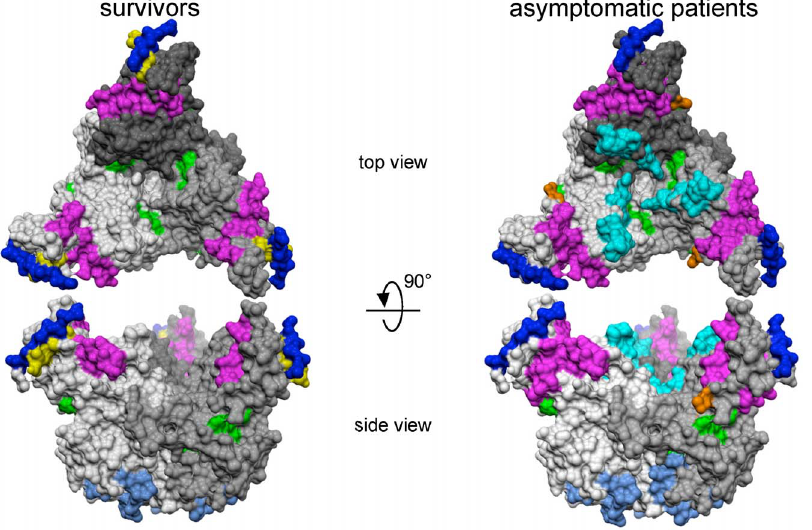
Figure 4. Crystal structure of the trimeric prefusion EBOV GP viewed from the top (above) and side (below) [21] . The three monomers in the complex are colored different shades of grey. Immunodominant regions identified in GP are indicated in color for survivors and asymptomatic patients. The color code matches that of the epitopes identified in Figure 3. Molecular surface of the GP trimer viewed from the side (left) and top (right), as viewed down the three-fold axis. Protein Data Bank file number: 3CSY.